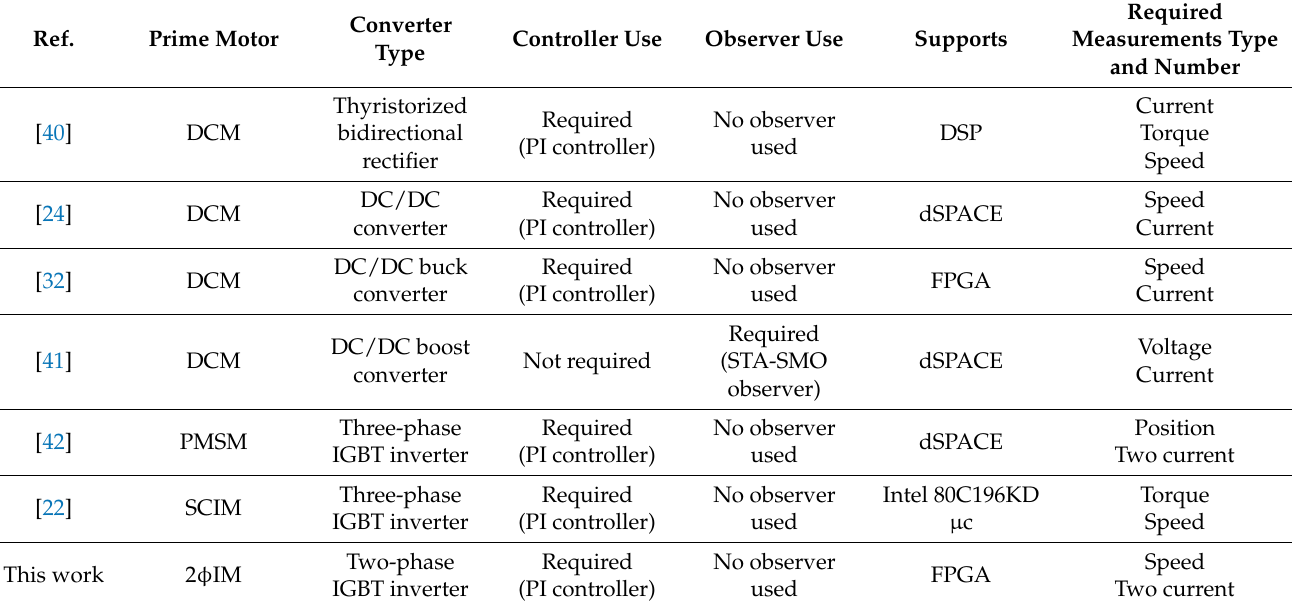
Table 1. Brief review of different WTE configurations and control.